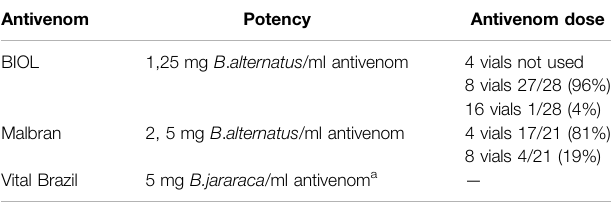
TABLE 1 | Potency and dose used of each group of antivenom. Antivenom Potency Antivenom